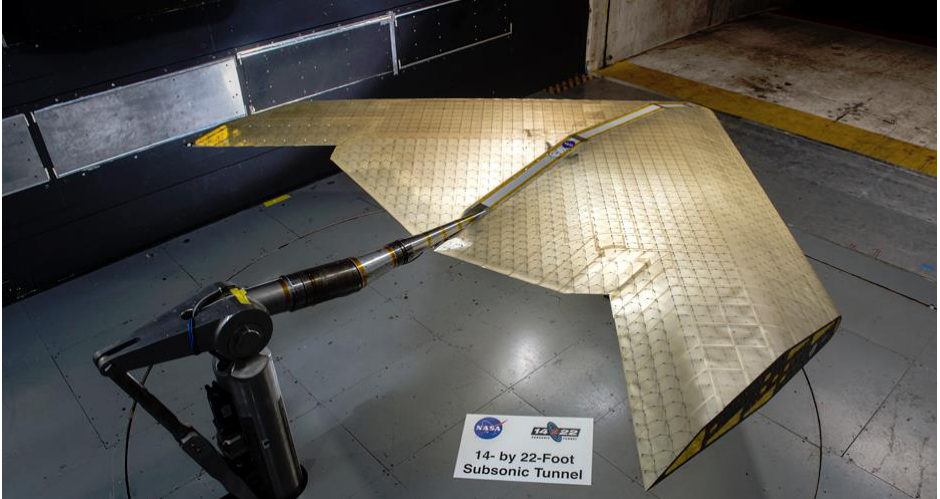
Figure 8. Passively morphing aircraft capable of shape adaptation to different flight conditions [106].